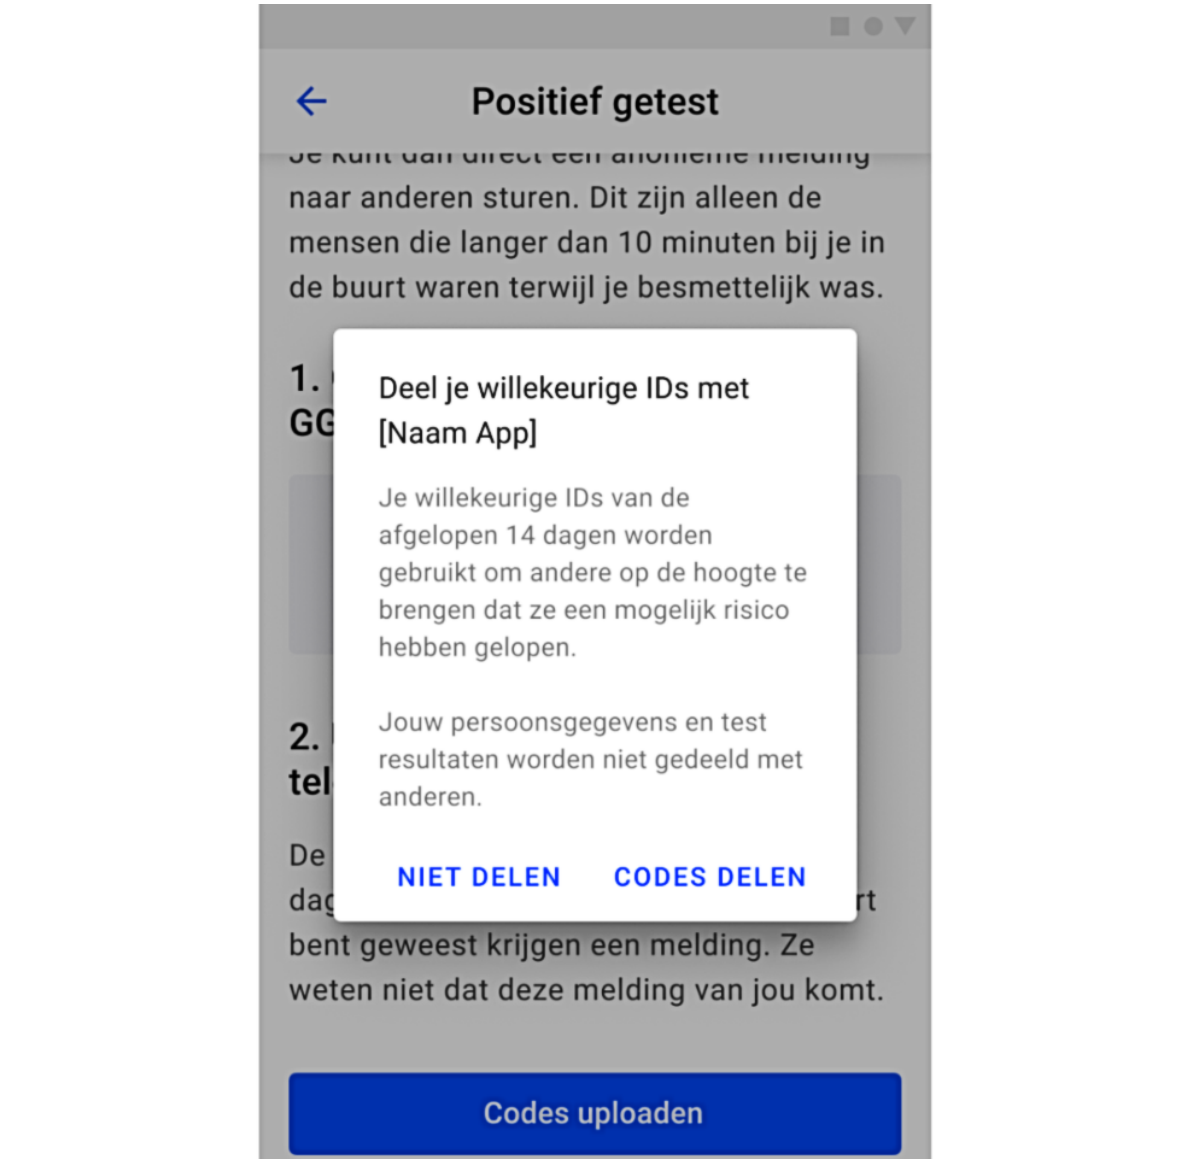
Figure 6. The notification that pops up after sharing the key, asking the user for permission to share their information and notify others after they click on Share the Key . The text reads: “Share your random IDs with [name of the app]. Your randomly generated IDs for the past 14 days will be used to notify others that they have been at increased risk. Your personal data and test results will not be shared with others.” The choice options are translated as “do not share” and “share